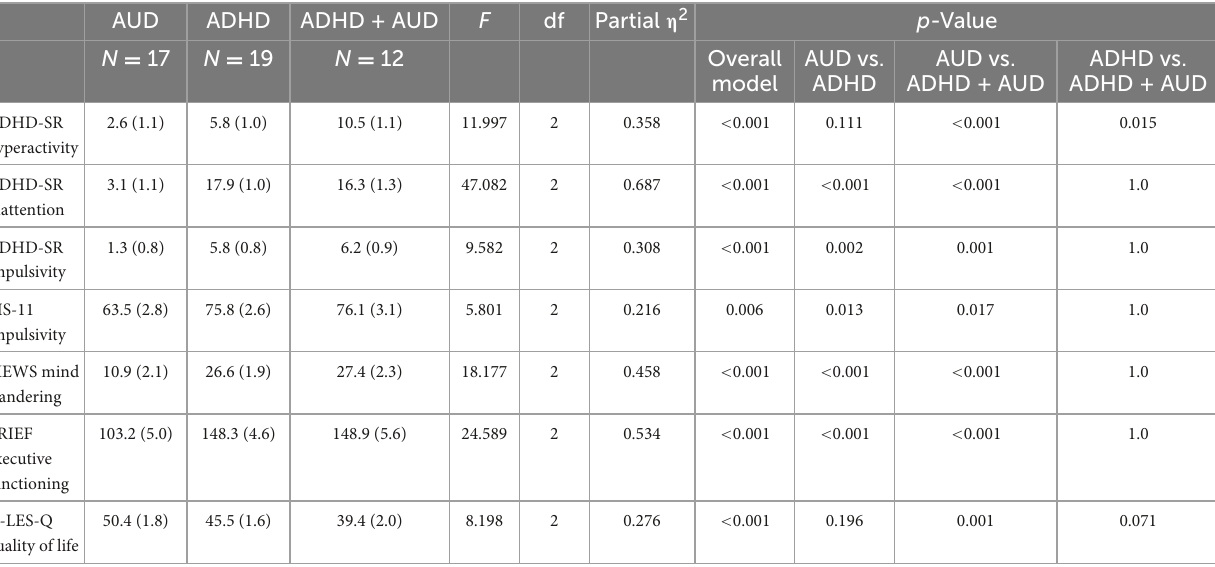
TABLE 3 Self-report